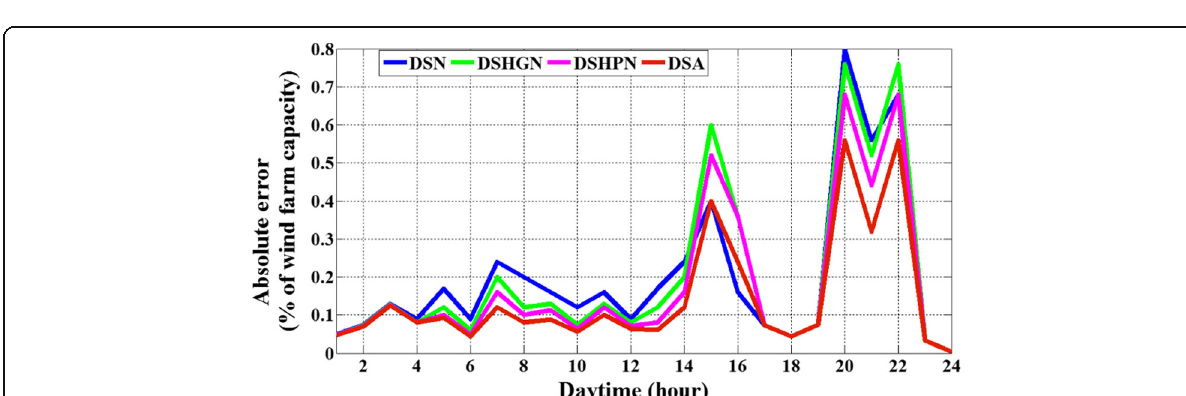
Fig. 9 Normalized absolute values of forecast errors for a spring